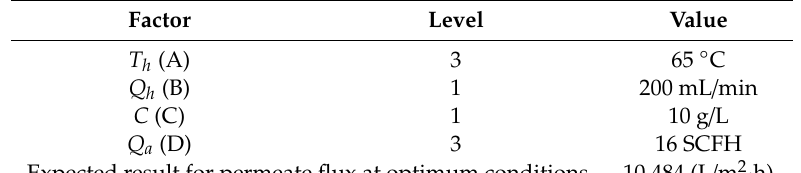
Table 6. Optimized operating conditions and predicted distillate flux based on the Taguchi method.